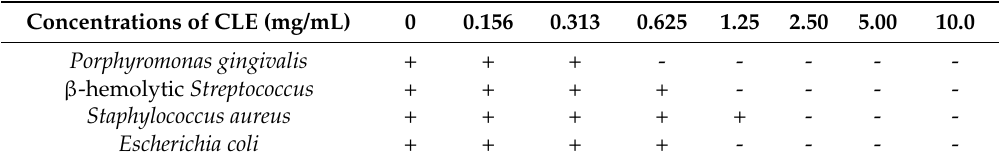
Table 3. Minimum inhibitory concentrations (MICs) of CLE against pathogens and opportunistic